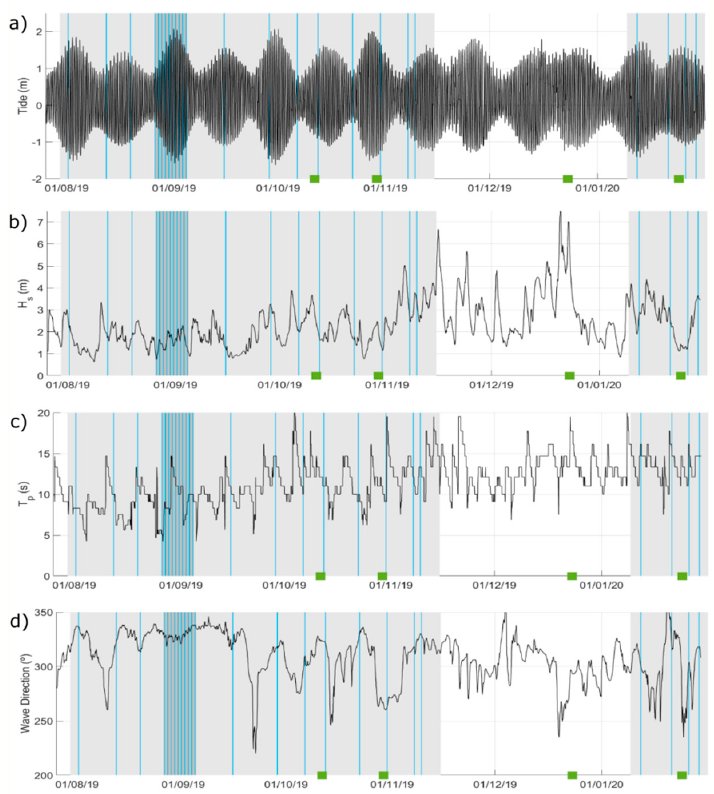
Figure 4. Hydrodynamics of the study site. ( a ) Tide level from Cascais tide gauge; ( b ) significant wave height; ( c ) wave period; and ( d ) wave direction (from Puertos del Estado). Light gray rectangles indicate the video-monitoring period, blue vertical lines indicate the days chosen for shoreline detection, and the green squares represent the days topographic surveys were performed during the monitored period.